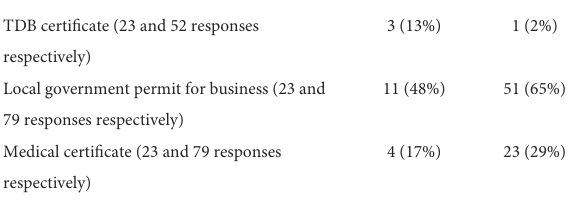
TABLE 1 Number (and percentage) of surveyed milk traders who have the required